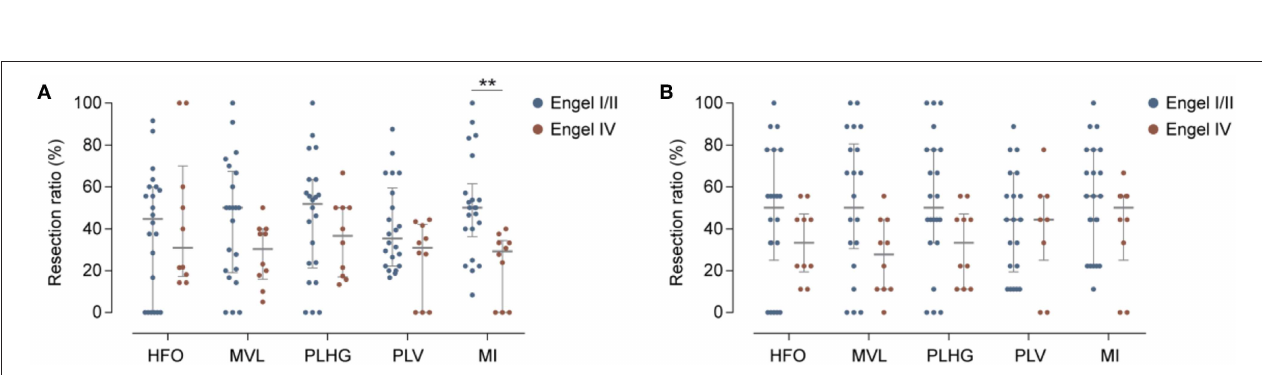
FIGURE 3 | Evaluation of phase-locked HFO measures. (A) Percentage of channels reaching the threshold for HFOs power or phase-locked HFO levels that were resected in patients with good (blue) or poor (red) outcome. Horizontal and vertical bars indicate the median and interquartile range, respectively. Only the MI measure showed significant differences between two groups. Detailed results [median (inter-quartile range)]: Engel I/II vs. Engel IV: HFOs: 44.8% (0–60) vs. 30.9% (18–60), P = 0.8; MVL: 50% (20–66) vs. 30.3% (17–40), P = 0.13; PLHG: 51.9% (23–63) vs. 36.6% (17–50), P = 0.28; PLV: 35.4% (22–57) vs. 30.1% (0–41), P = 0.22; MI: 50% (40–57) vs. 29.3% (0–33); P = 0.0024**). (B) Same as (A) , but for early nine channels. None of the measures showed significant differences between two groups. Detailed results: Engel I/II vs. Engel IV: HFOs: 50% (33–77) vs. 33.3% (22–44), P = 0.26; MVL: 50% (33–77) vs. 27.7% (11–44), P = 0.052; PLV: 44.4% (22–66) vs. 44.4% (33–55), P = 0.61; PLHG: 50% (33–77) vs. 33.3% (11–44), P = 0.08; MI: 55% (22–77) vs. 50% (IQR: 33–55), P = 0.27.